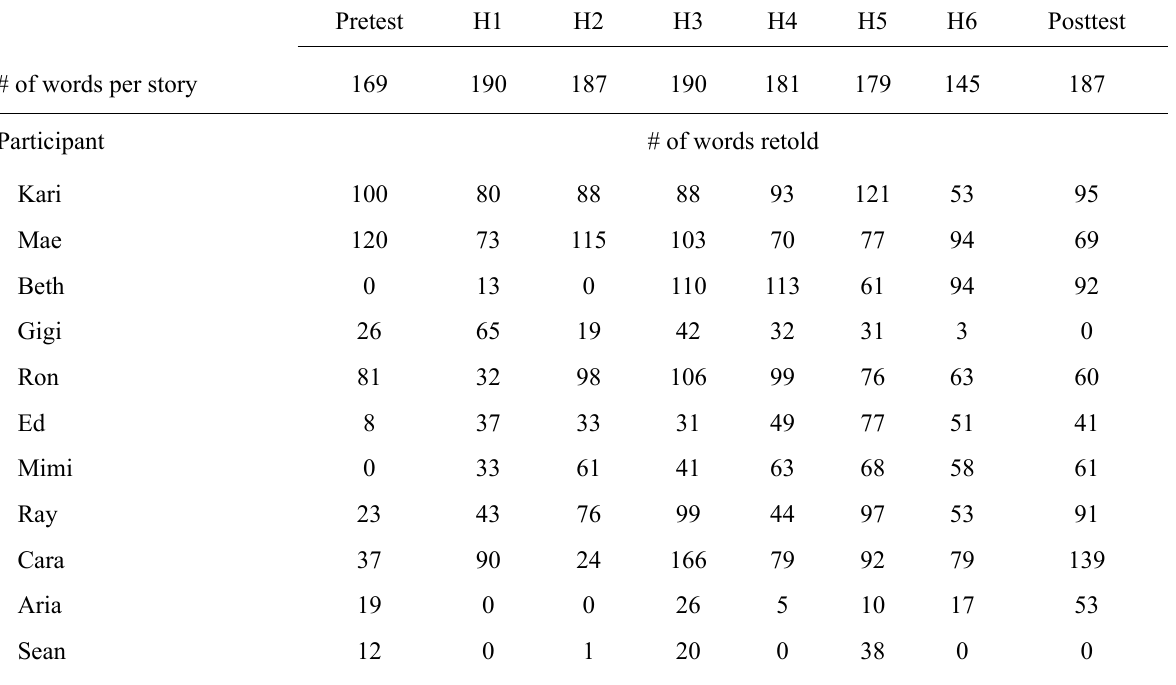
Table 1 Total Number of Words in Each Story and Number of Words Retold in Each Story by Each Participant